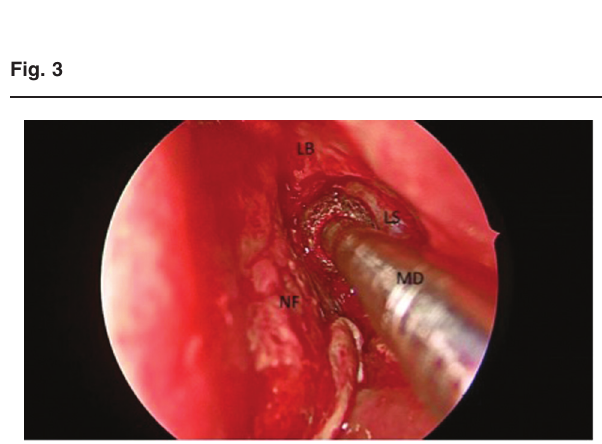
Use micro-drill: widening of bony ostium until exposure fundus of lacrimal sac superiorly, to anterior and posterior limit of lacrimal sac and to inferior turbinate inferiorly. LB: lacrimal bone, LS: lacrimal sac , MD: diamond bur of micro-drill, NF: nasal